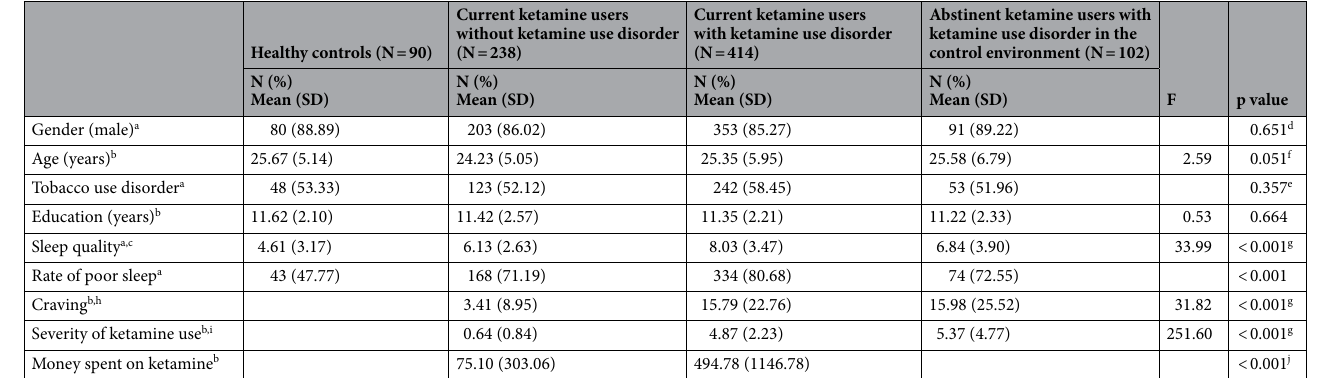
Table 1. Demographic data, sleep quality and ketamine-related characteristics in healthy controls, current ketamine users and abstinent ketamine users (N = 844). a Values are presented as N (%); b values are presented as mean (SD); c sleep quality was measured using the PSQI; d analyzed by chi-square tests with female gender as the reference; e analyzed by chi-square tests with participants without tobacco use disorder as the reference; f analyzed by ANOVA; g analyzed by ANOVA while controlling for the effects of age, gender, education and tobacco use disorder; h measured by the VACS; i measured by the SDS; j analyzed by t